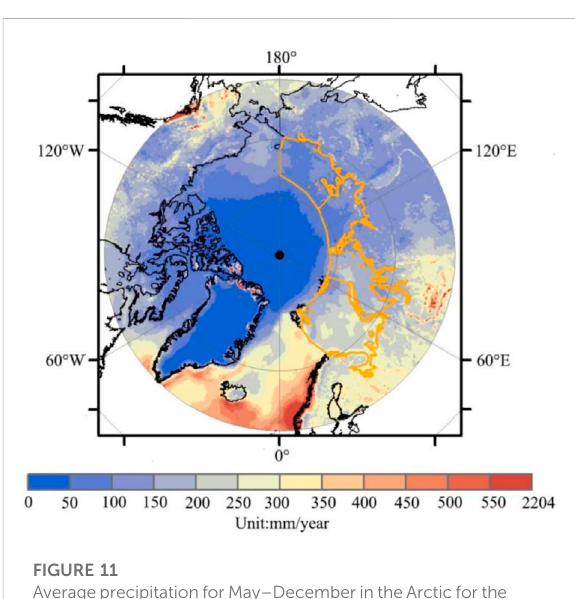
FIGURE 11 AverageprecipitationforMay – DecemberintheArcticforthe period 2011 –